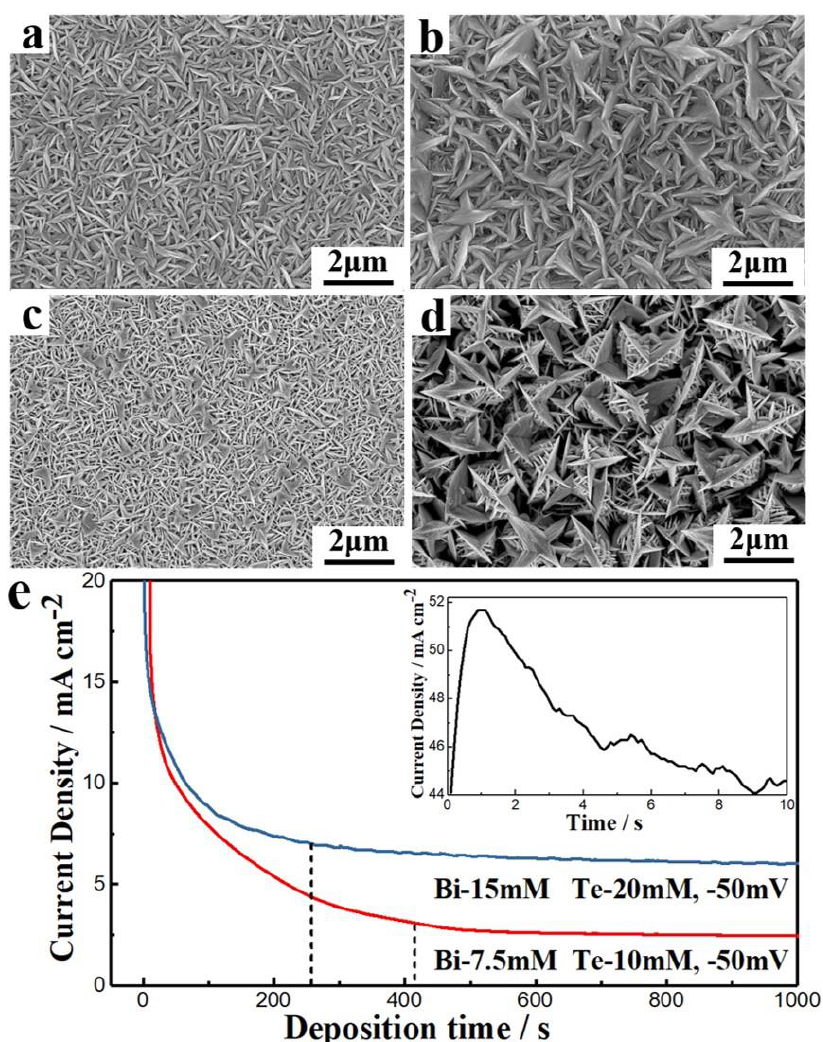
Figure 3. ( a , c ) The deposit morphologies when deposited at −50 mV and −90 mV from the electrolyte containing 7.5 mM Bi and 10 mM Te. ( b , d ) The morphologies when deposited at −50 mV and −90 mV from the electrolyte containing 15 mM Bi and 20 mM Te. ( e ) Current density vs. deposition time at −50 mV for 7.5 mM Bi and 10 mM Te, and 15 mM Bi and 20 mM Te.